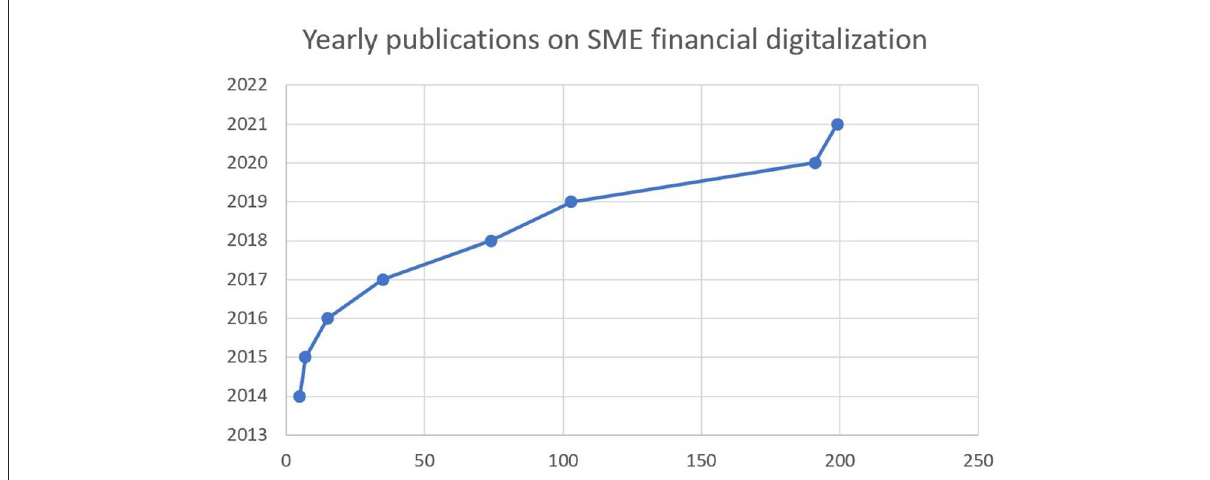
FIGURE2 Scholarly publications on SME financial digitalization, number by year. Source: The authors.